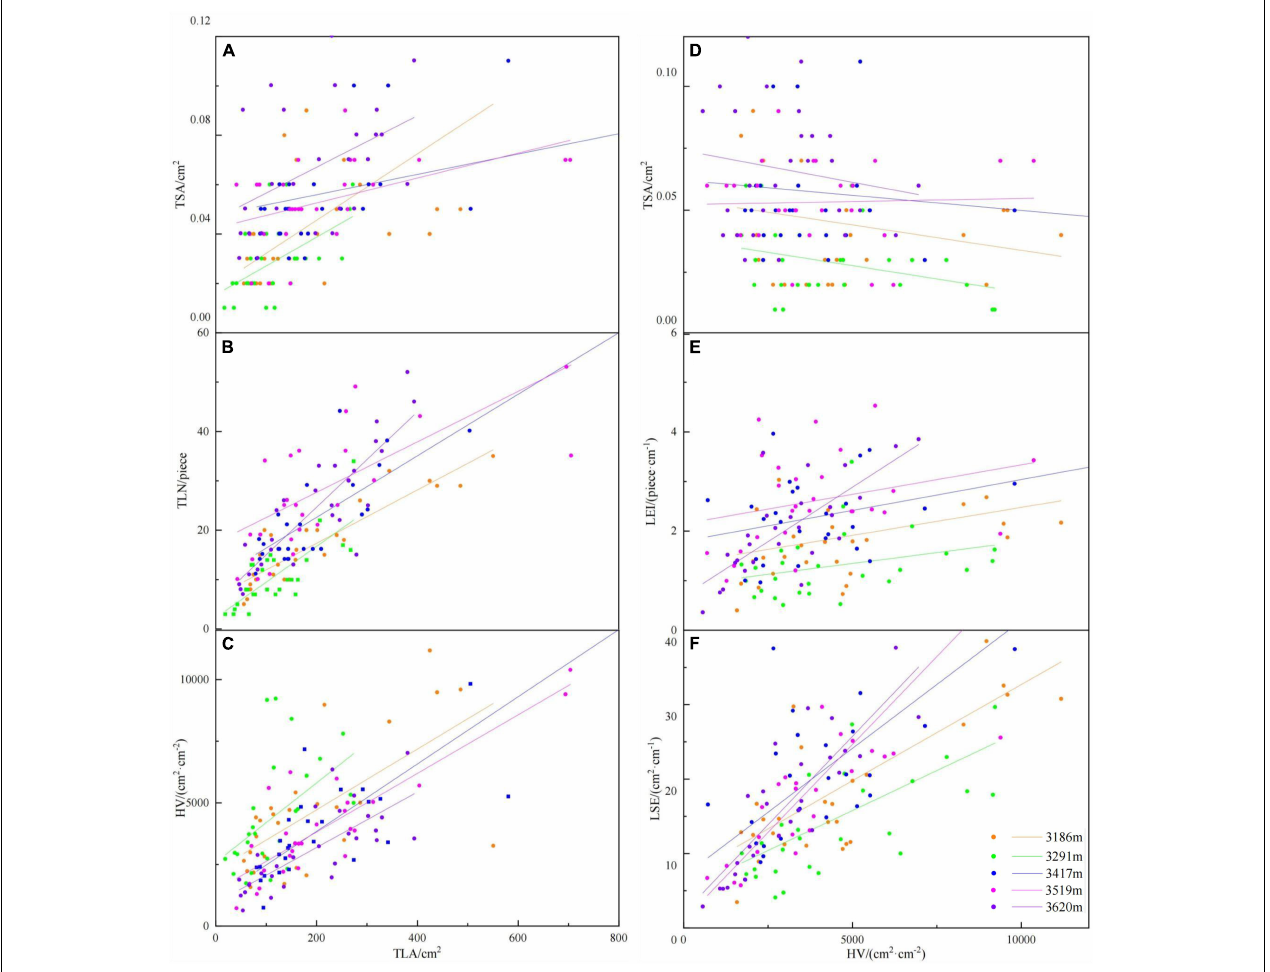
FIGURE 6 | The scaling relationships between functional traits of current-year twigs at different altitudinal gradient. (A) The scaling relationship between Total leaf area on each twig (TLA) and Twig cross-sectional sapwood area (TSA); (B) the scaling relationship between Total leaf area on each twig (TLA) and Total number of leaves on each twig (TLN); (C) the scaling relationship between Total leaf area on each twig (TLA) and Huber value (HV); (D) the scaling relationship between Huber value (HV) and Twig cross-sectional sapwood area (TSA); (E) the scaling relationship between Huber value (HV) and intensity of leaf growth based on the twigs (LEI); and (F) the scaling relationship between Huber value (HV) and leaf spreading efficiency (LSE). TABLE 4 | RDA analysis of functional traits of leaf and current-year twigs and environmental factors. Statistic Leaf